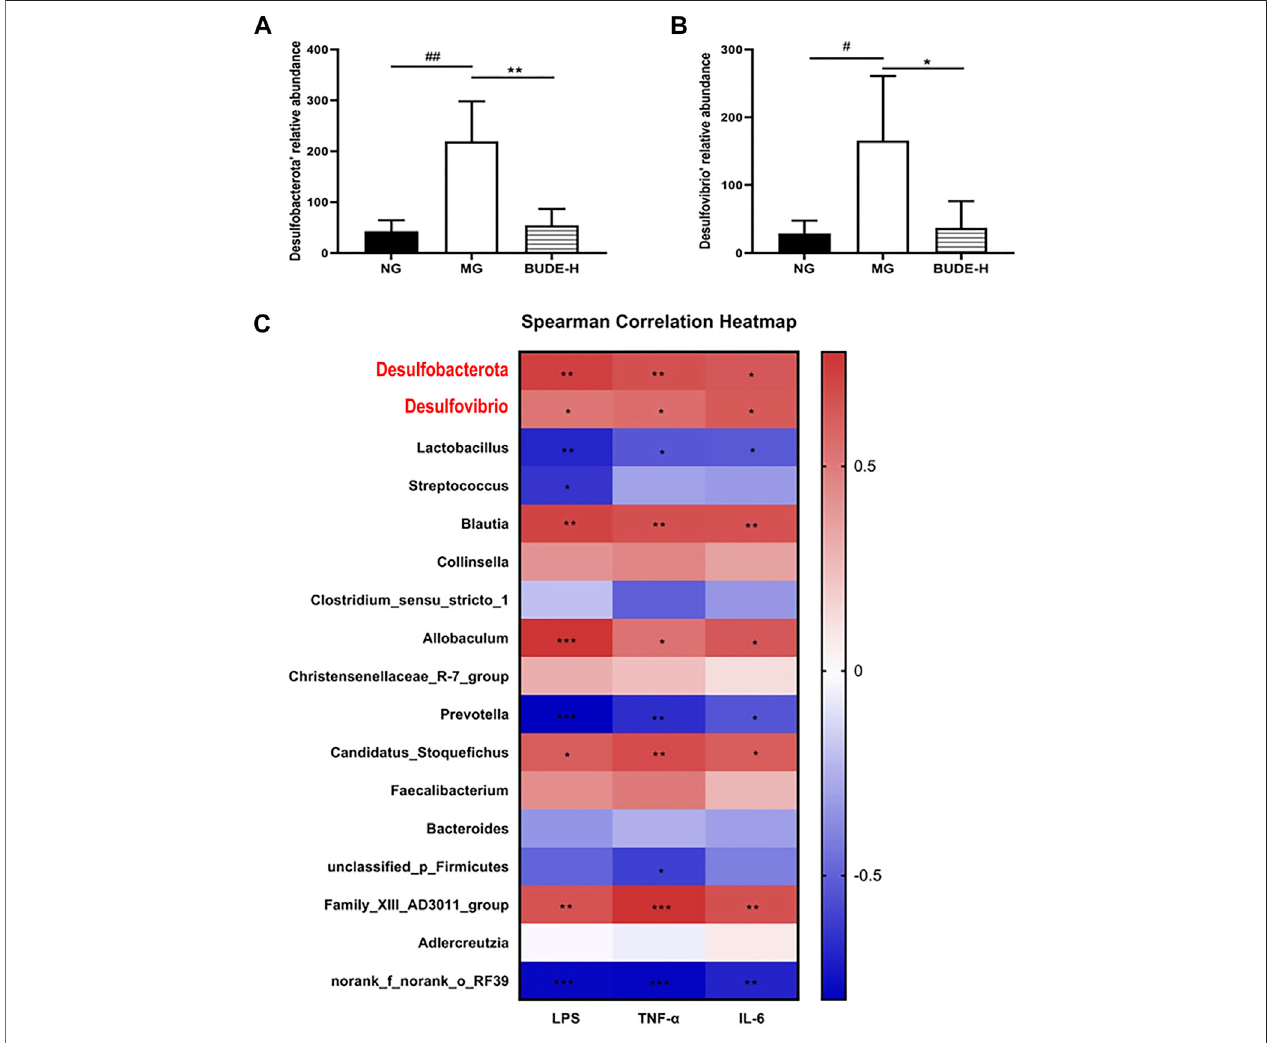
FIGURE 7 | Correlation analysis between LPS and intestinal fl ora. (A) Relative abundance of Desulfobacterota . (B) Relative abundance of Desulfovibrio . (C) The spearman correlation between LPS, TNF- α , IL-6 and intestinal fl ora. Compared with the normal control group # p < 0.05, ## p < 0.01; compared with the model control group * p < 0.05, ** p < 0.01, n (cid:2)